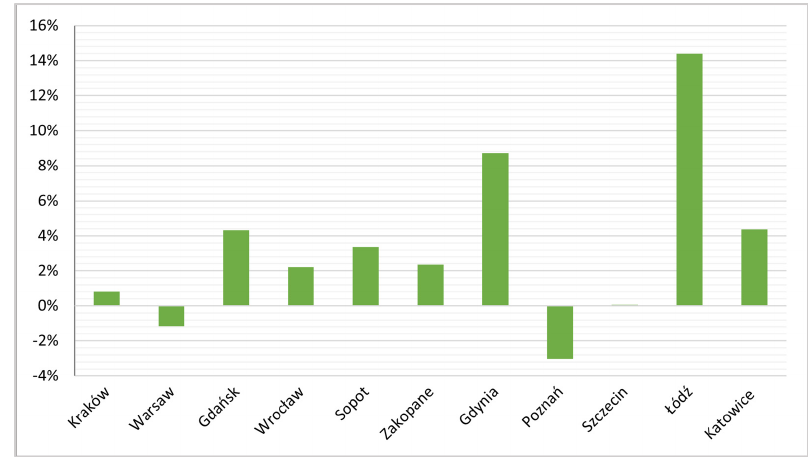
Figure 10. Growth dynamics indices for entire home rentals, September 2019 to September 2021. In September 2019, in the examined cities, private rooms represented from 10% (Kraków) to over 25% ( Ł ód ź ) of active rentals, but in the study period most of these percentages dropped in most of the cities, except Warsaw, Pozna ń and Szczecin (Figure 11). The largest decreases (of over 40%) were recorded in Ł ód ź , where their initial level had been highest, and in the Tri-City—mainly in Gdynia (by over 30%) (Figure 12).